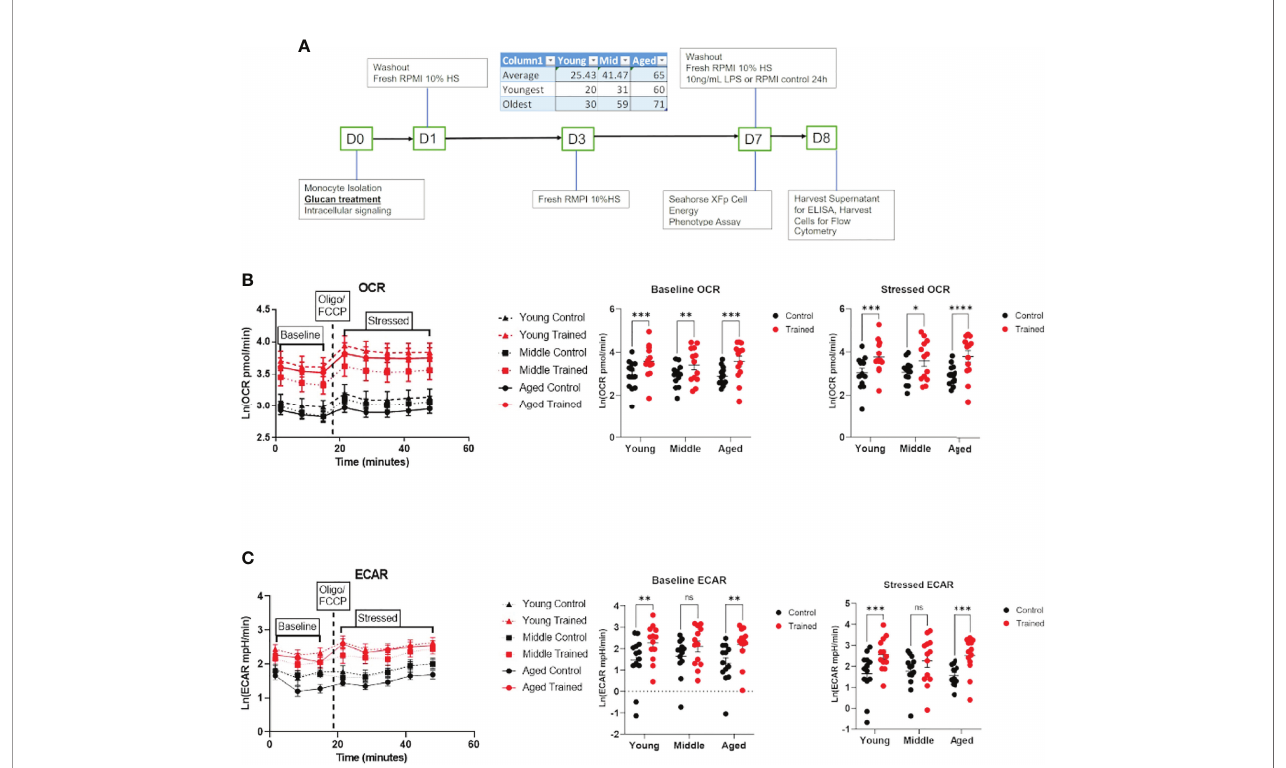
FIGURE 1 | Immune training increases overall metabolic rate of monocytes across all age groups. (A) Ex vivo trained immunity protocol. (B) Baseline and stressed oxygen consumption rate (OCR) 7 days after b – glucan or PBS treatment. (C) Baseline extracellular acidi fi cation rate (ECAR) and stressed ECAR 7 days after b – glucan or PBS treatment. Mixed effect model and S ̌ ı ́ da ́ k ’ s multiple comparisons test (*P ≤ 0.05, **P ≤ 0.01, ***P ≤ 0.001, ****P ≤ 0.0001) were used to compare (B, C) (N=13). ns, not signi fi cant.